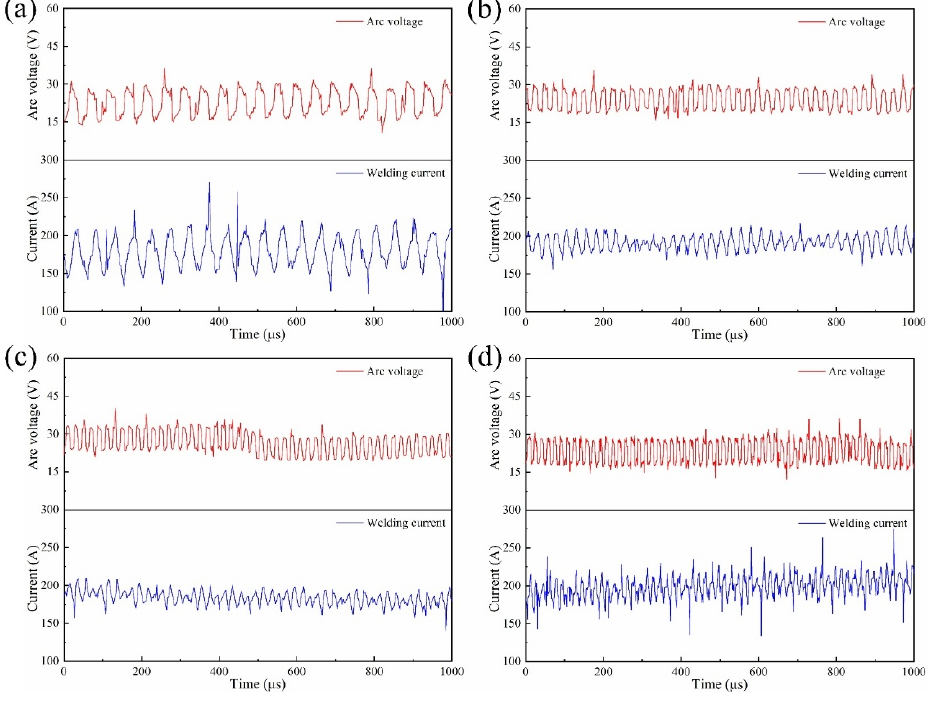
Figure 6. Arc voltage and coupling current waveforms at different ultrasonic frequencies with an ultrasonic excitation voltage of 40 V: ( a ) 20 kHz; ( b ) 40 kHz; ( c ) 50 kHz; ( d ) 60 kHz.